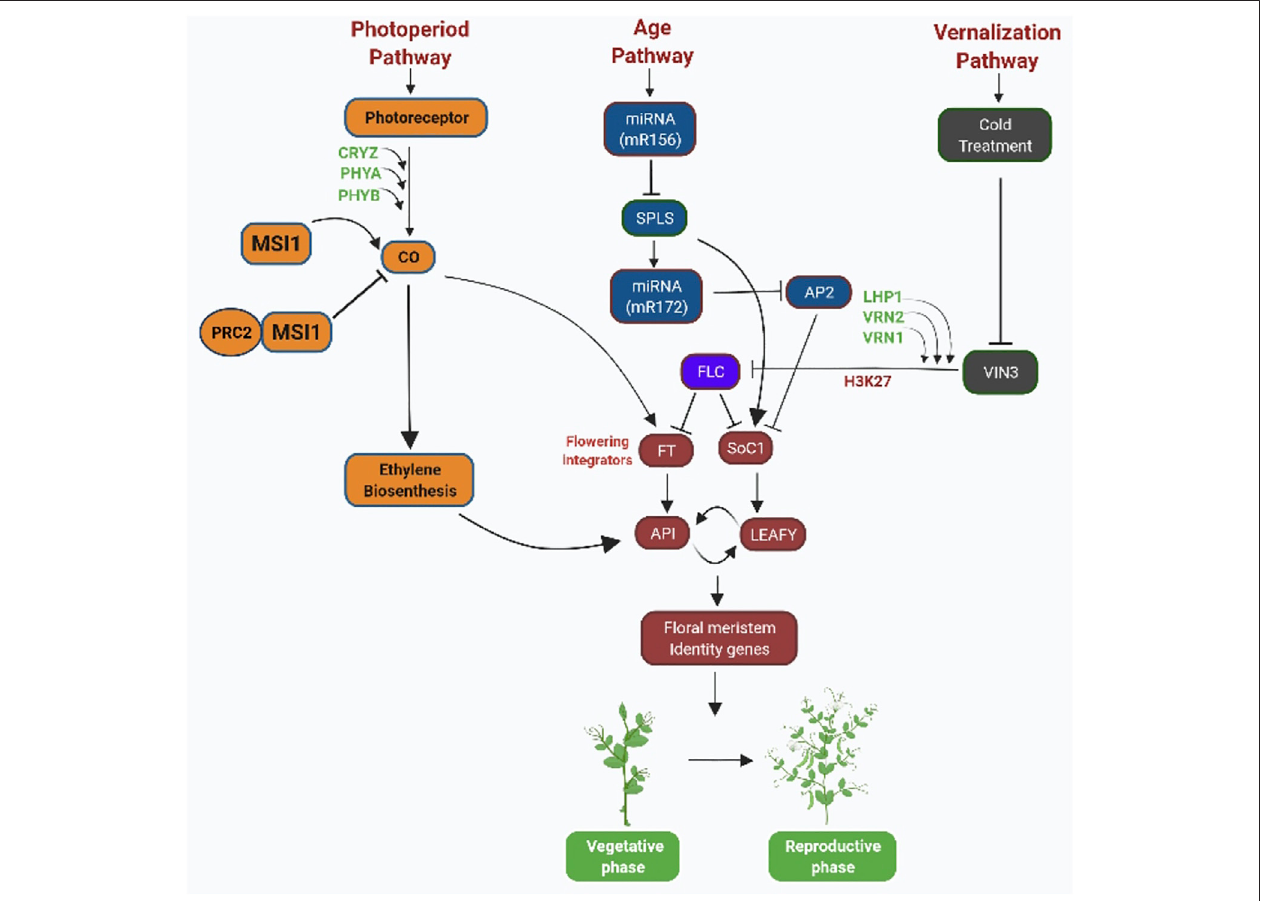
FIGURE 2 | Role of epigenetic modi fi cations in controlling fl owering time in co-relation with biological pathways: fl owering is induced by a number of molecular pathways that respond to external and internal signals. Flower integrator genes such as FT and SOC1 are regulated by fl owering activators and repressors. In the photoperiodic pathway, chromatin modi fi cations involve the well-conserved histone binding protein MULTICOPY SUPRESSORS OF IRA1 (MSI1) – like protein family. MSI1-like protein forms a complex with ubiquitous protein, i.e., POLYCOMB REPRESSIVE COMPLEX 2 in Arabidopsis and controls the switch to fl owering. MSI1 acts in the normal expression of CO in long day (LD) plants. Reduced expression ofCO in msi1 mutantsleads toFT and SOC1 repression. In age pathway, miR156 and miR172 acts as positive regulators of SOC1 gene. Vernalization leads to the expression of VIN3. VIN3 represses FLC transcription by binding with PcG protein (VRN1, VRN2, LHP1). PcG proteins epigenetically modify chromatin of FLC by trimethylation of